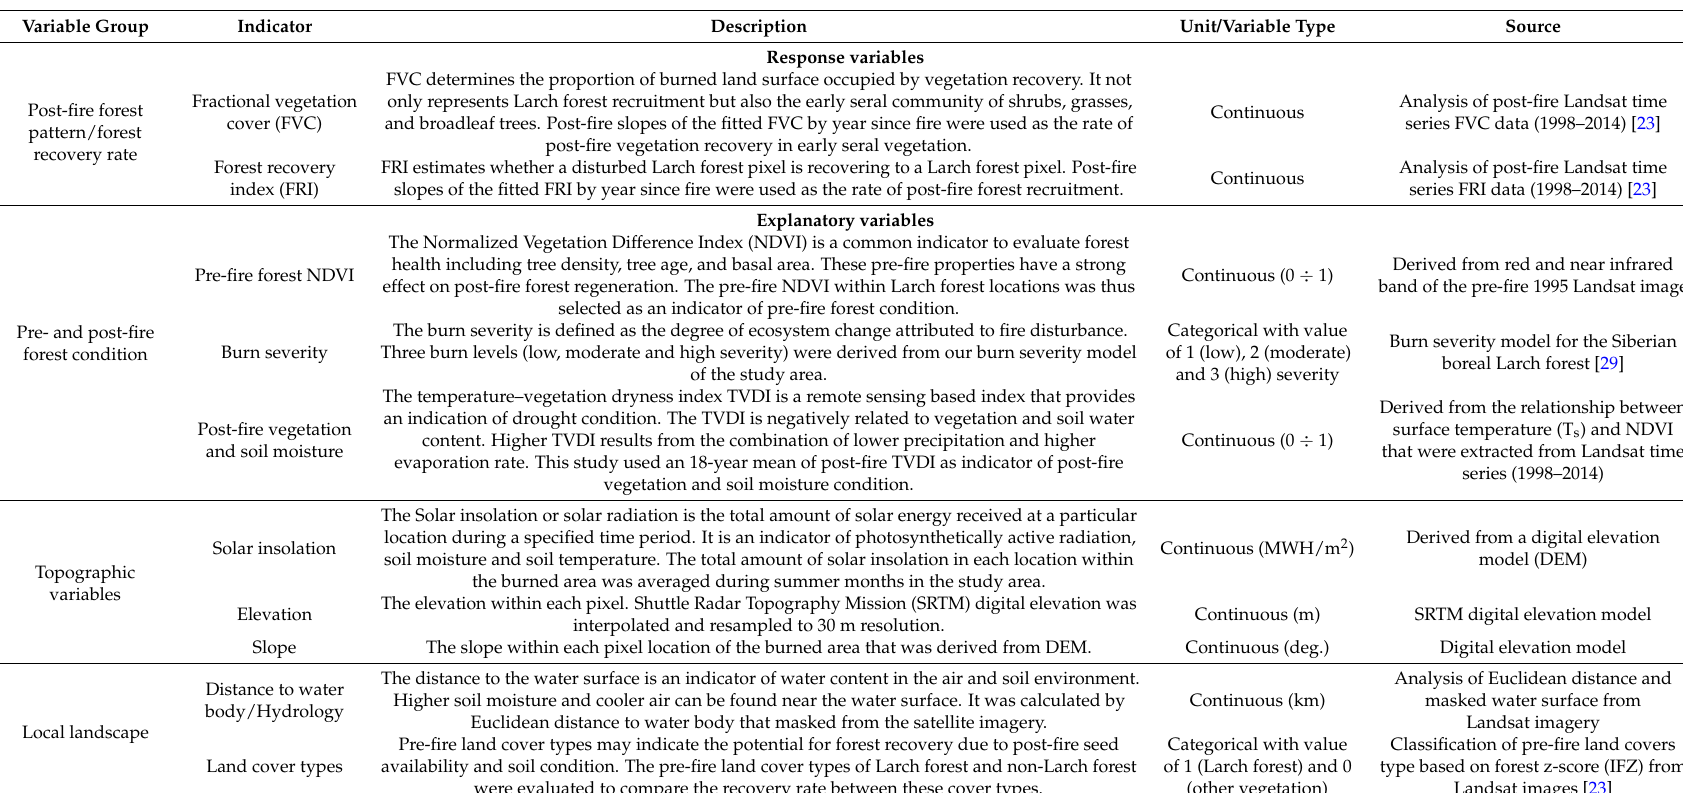
Table 2. Fire disturbance attributes and environmental factors as potential predictors of post-fire forest